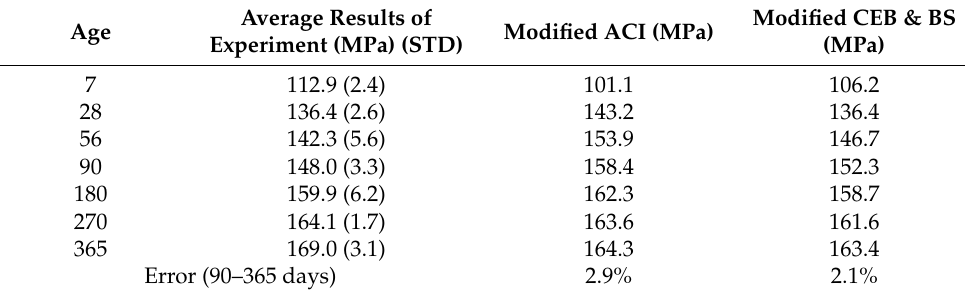
Table 3. Experiment results in air curing compared with the modified prediction models. Average Results